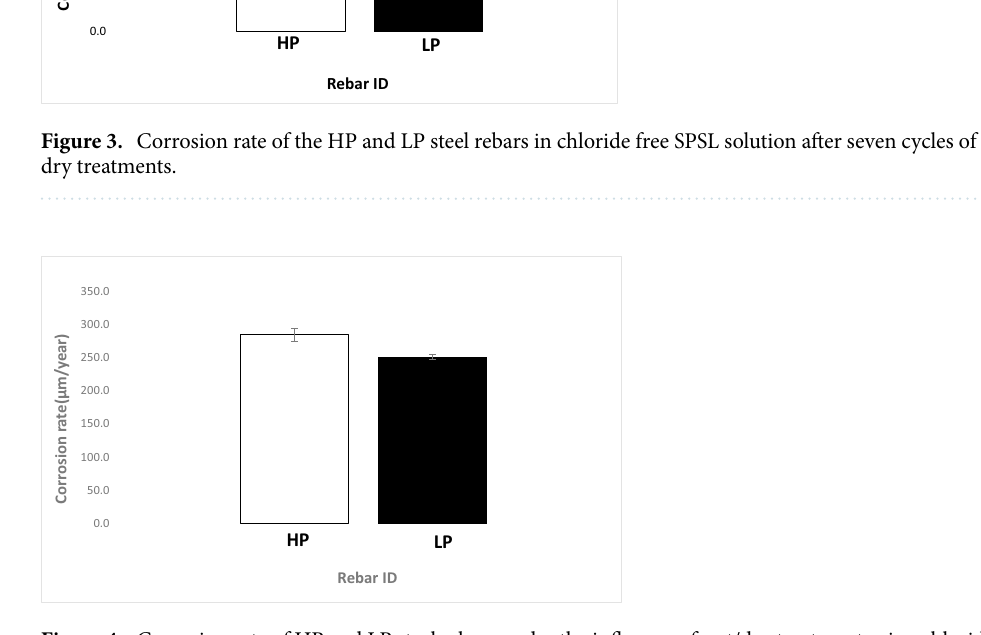
Figure 4. Corrosion rate of HP and LP steel rebars under the influence of wet/dry treatment using chloride added SPSL